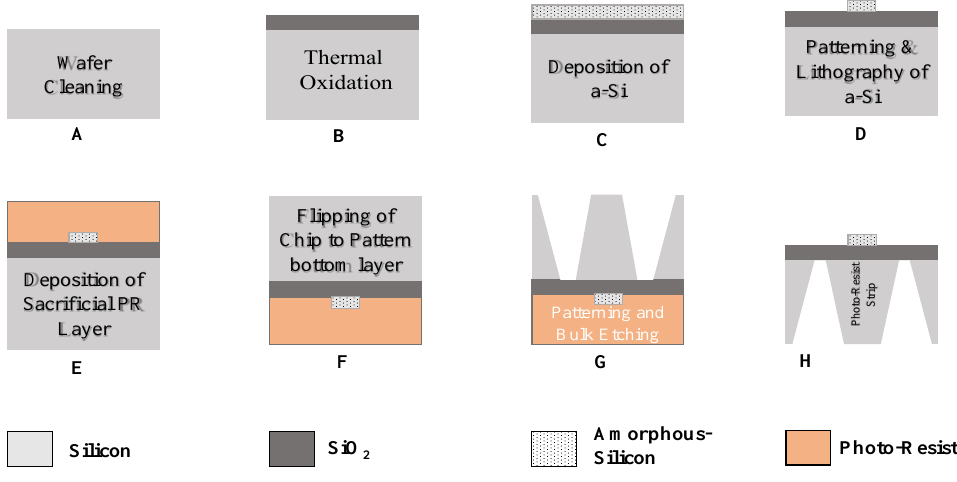
Figure 6. Proposed fabrication